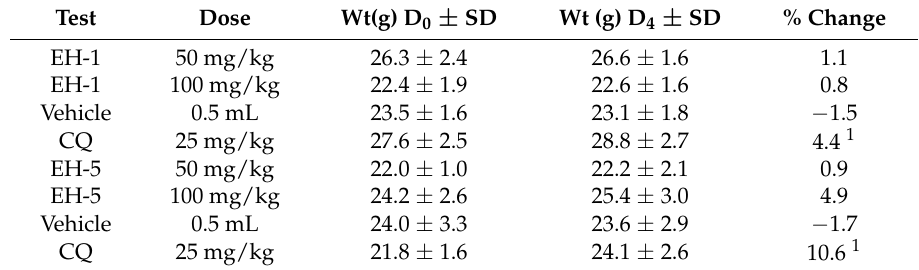
Table 6. Body weight of Plasmodium berghei- infected mice before and after administration of EH-1 and